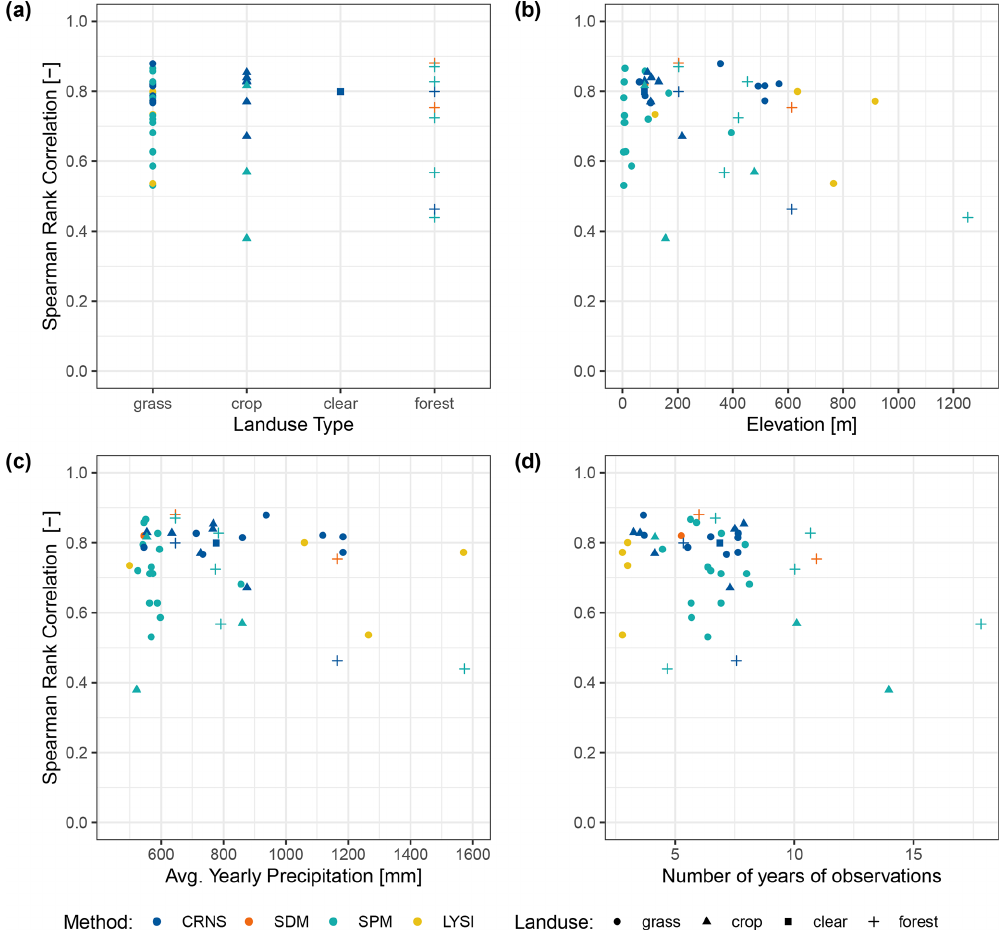
Figure 4. Spearman rank correlation coefficients of the simulated versus observed deseasonalized SM anomalies against site characteristics: (a) land use, (b) elevation, (c) average yearly precipitation, and (d) length of the time series. See Table 2 for a detailed overview per location. Colors denote the SM data method (cosmic-ray neutron sensing, CRNS; spatially distributed measurements, SDM; single profile measure- ments, SPM; and lysimeter, LYSI) and shapes the land use types reported at the locations (abbreviated as following: grass = grassland, clear = forest clearing, LYSI =